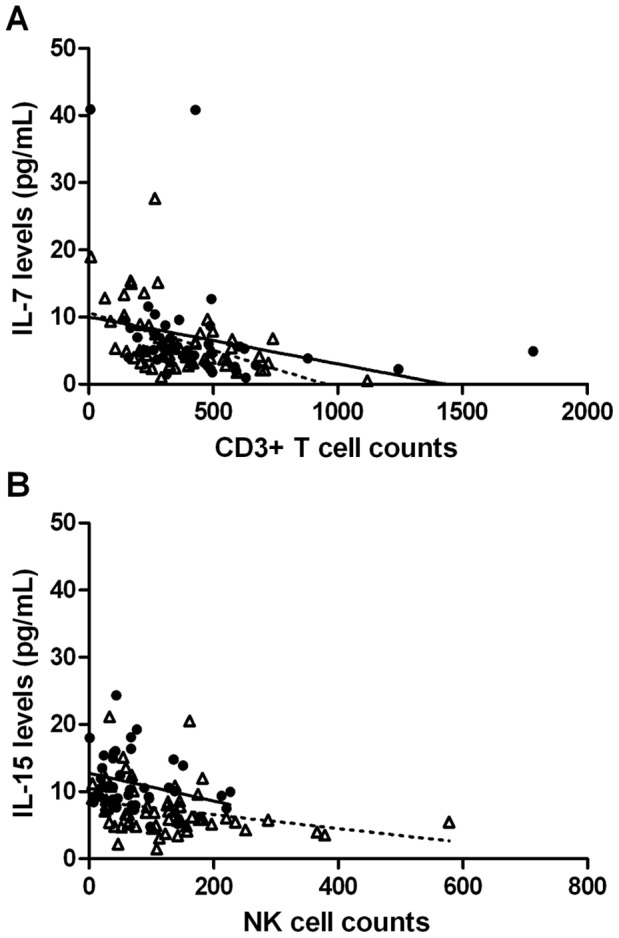
Correlation between CD3+ T cell counts and IL-7 levels on day 14 (black circles and continuous line) and on day 28 (open triangles and broken lines) after transplantation (A).Correlation between NK cell counts and IL-15 levels on day 14 (black circles and continuous line) and on day 28 (open triangles and broken lines) after transplantation (B).